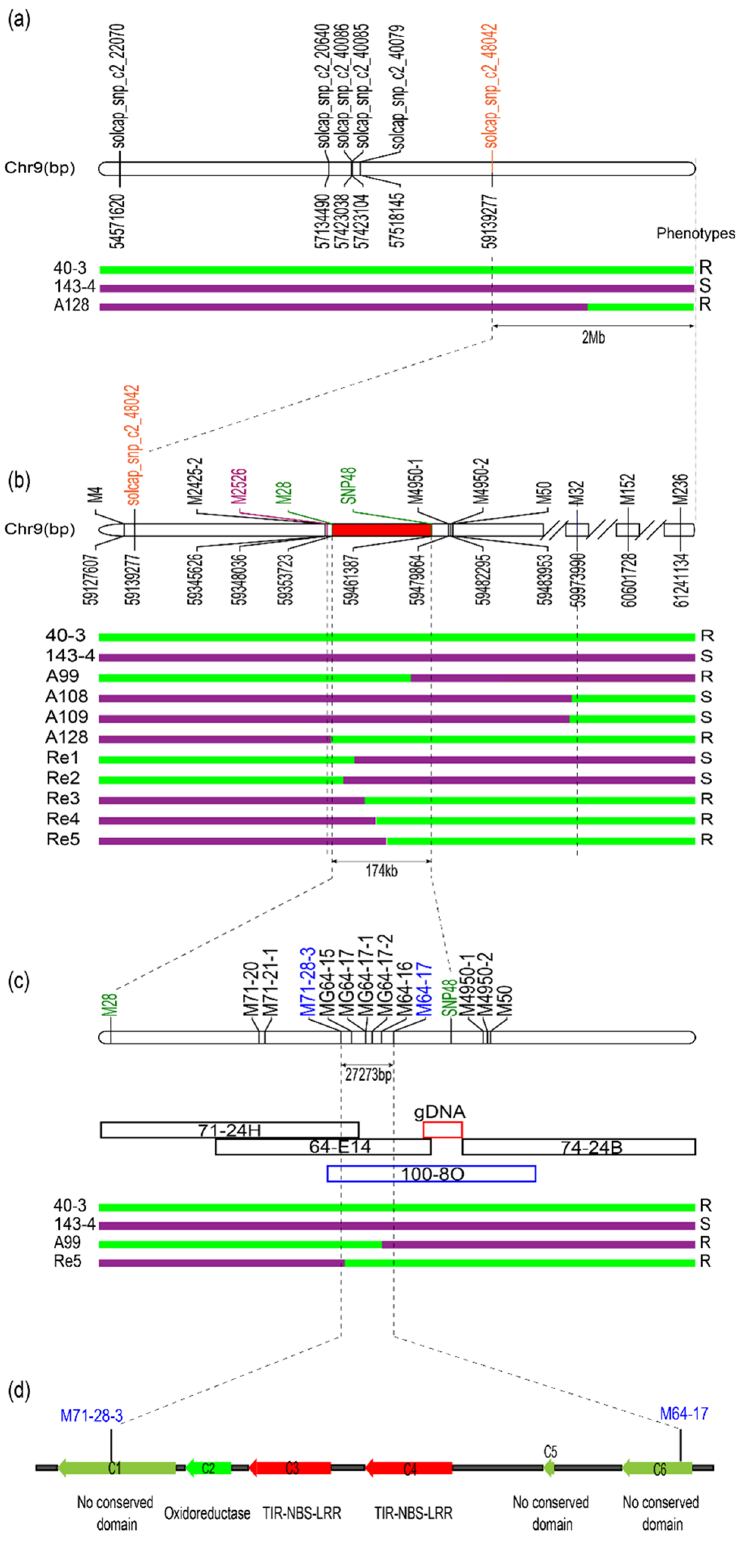
Figure 2. Map-based cloning of Ry chc in potato. ( a ) Preliminary mapping of Ry chc . Ry chc was preliminarily mapped to the end of chromosome 9 using six SNPs that were significantly linked to Ry chc and recombinant A99; ( b ) Fine mapping of Ry chc . The Ry chc locus was fine mapped to a 113,351-bp interval between M28 and SNP48. Markers indicated with a bold font were used for BAC library screening; ( c ) Physical locations of gene markers. The physical map was designed based on the se- quence of a BAC clone from a library constructed from S. chacoense accession 40-3 and used for the